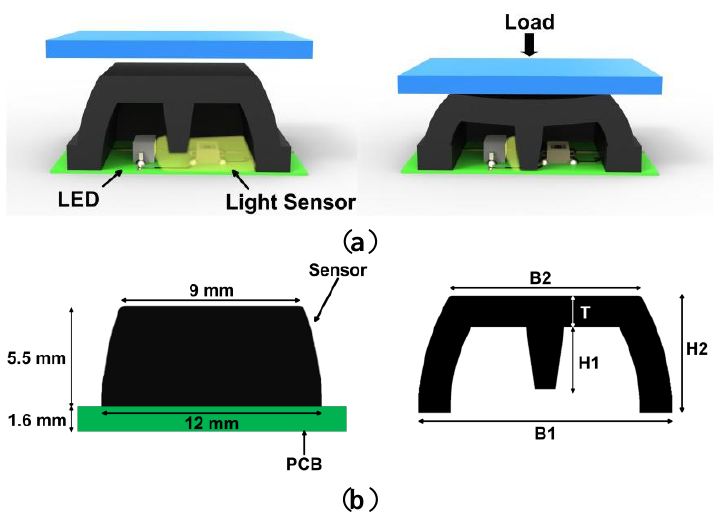
Figure 2. ( a ) Overview of the sensitive element and its functioning principle; ( b ) dimension and cross section of the silicone